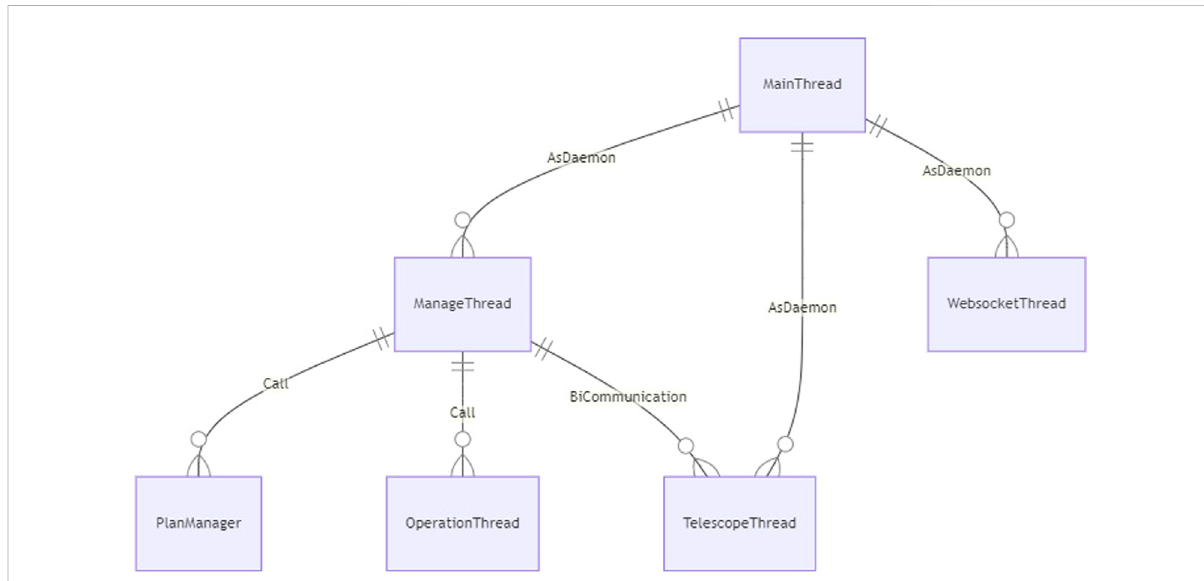
Modules and relations among them within the TCS program structure. MainThread, ManageThread, WebsocketThread, and TelescopeThread are long-lived daemon thread to maintain the system operation. The extensible OperationThread performs the observation plan and PlanManager provide plan acquisition